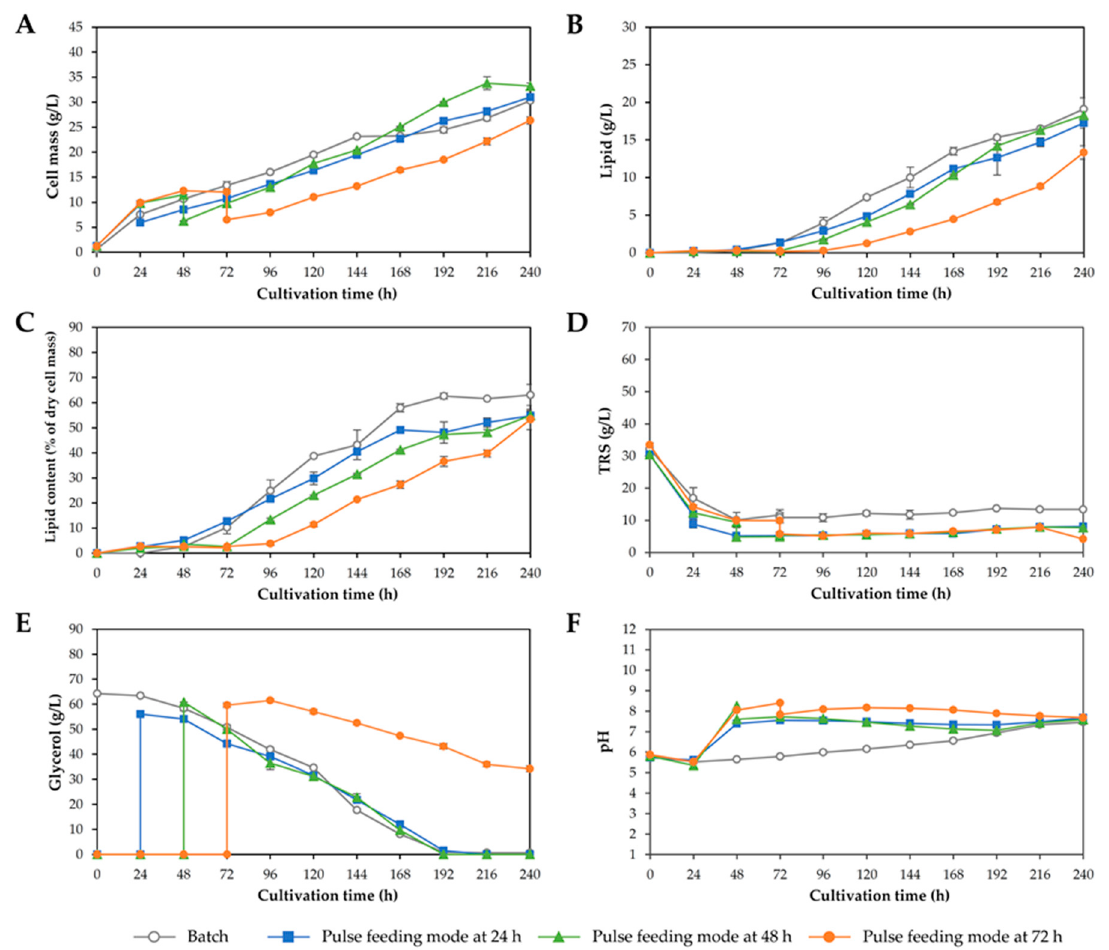
Figure 4. Lipid production by Rhodosporidiobolus fluvialis DMKU-SP314 in a 3 L stirred-tank fermenter using batch cultivation and two-stage fed-batch cultivation with pulse feeding modes at different starting time points of 24, 48, and 72 h after batch operation. ( A ) Cell mass, ( B ) lipid, ( C ) lipid content, ( D ) total reducing sugars (TRS), ( E ) glycerol, and ( F ) pH.